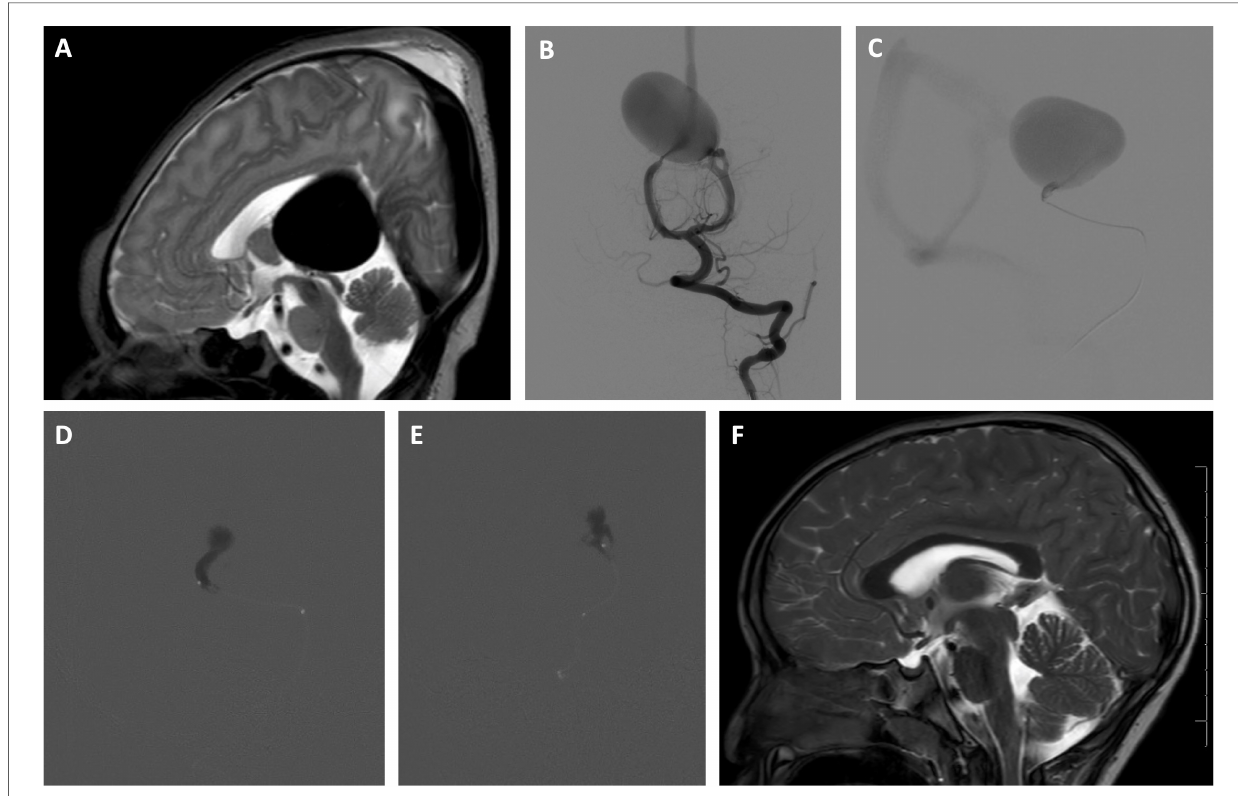
FIGURE 2 Two-stage embolization of VOGM with n-BCA glue using adjunctive RVOP for fl ow control. A newborn male, initially found to have a VOGM on prenatal ultrasound performed late in pregnancy because of maternal risk factors was asymptomatic and monitored closely during the fi rst 3 months of life. Use of the RVOP technique was selected for this case given the anticipated rapid transit of embolysate through the hight- fl ow shunt. A transvenous approach was not selected due to the anticipated challenge of navigating a microcatheter through the profoundly dilated venous pouch. A transarterial balloon- assisted embolization was not selected due to multiple high- fl ow arterial inputs that could continue to propel the embolysate downstream despite balloon in fl ation. Utilizing the RVOP adjunctive technique, a two-stage transarterial acrylic embolization with adjunctive right ventricular overdrive pacing was performed resulting in angiographic cure. At three years follow up, the patient is neurologically normal and attending preschool with normal development. ( A ) Sagittal T2 weighted MR image of the brain obtained on day of life 1 shows massively dilated aneurysmal median prosencephalic vein, consistent with vein of Galen malformation. ( B ) Early arterial phase of selective left vertebral artery angiogram in frontal projection just prior to fi rst stage embolization at 3 months of age shows multiple, bilateral mural arteriovenous macro fi stulae formed between medial posterior choroidal arteries and aneurysmally dilated median prosencephalic vein (MPV). ( C ) Microcatheter angiogram (lateral projection) of mural arteriovenous shunt supplied by left medial posterior choroidal artery performed through Echelon 10 ® microcatheter (Medtronic, Santa